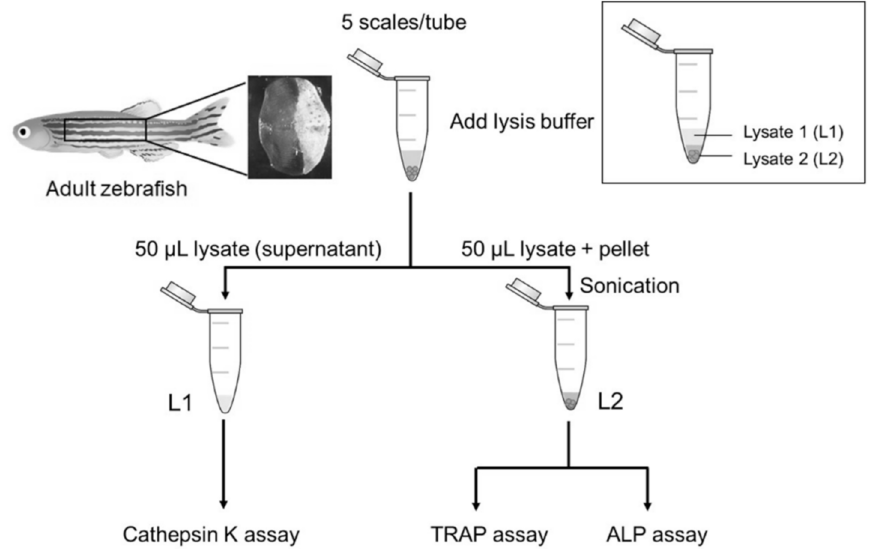
Figure 5. The schematic diagram of the scale lysis method. Five fish scales were pooled in a microcentrifuge tube. When starting an experiment, the scales were incubated in lysis buffer and then centrifuged at 17,400 × g . The first half of the lysate (supernatant) was collected for cathepsin K assay. The remaining lysate was sonicated and then used for TRAP and ALP